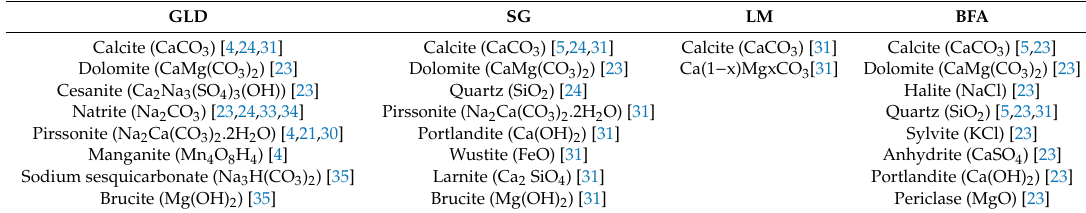
Table 3. Mineral phases in GLD, SG, LM, and BFA identified by